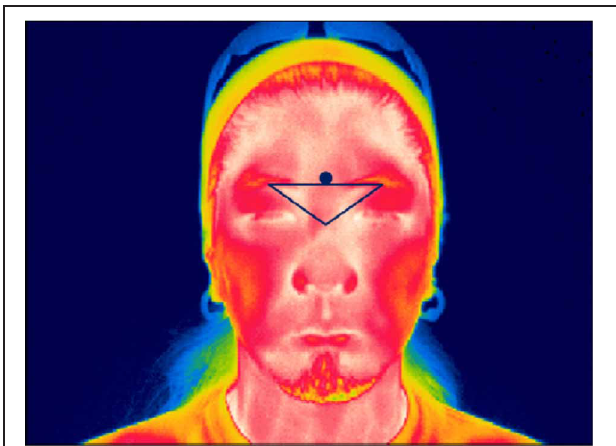
FIGURE 1 | A sample thermal image showing the Area of Interest (AOI) covering the periorbital regions (left and right corners of the inverted triangle) and the metallic tracking sticker (black